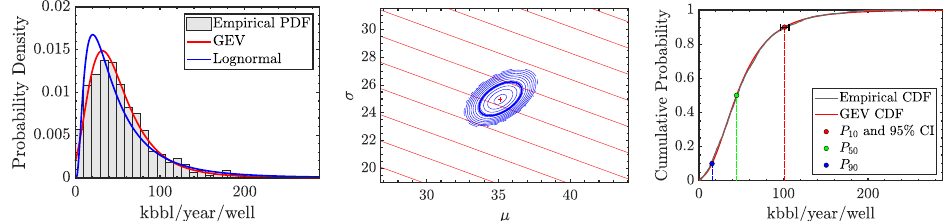
Figure 5. Example of fitting the first year on production of a well cohort in the Delaware Bonespring [2008–2013] with a Generalized Extreme Value (GEV) distribution. From this match, ξ = 0.1412, µ = 35.12, and σ =